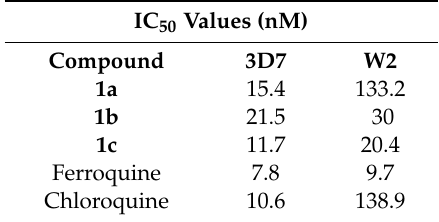
Table 1. In vitro activities of compound 1a – c against P. falciparum strains (3D7 and